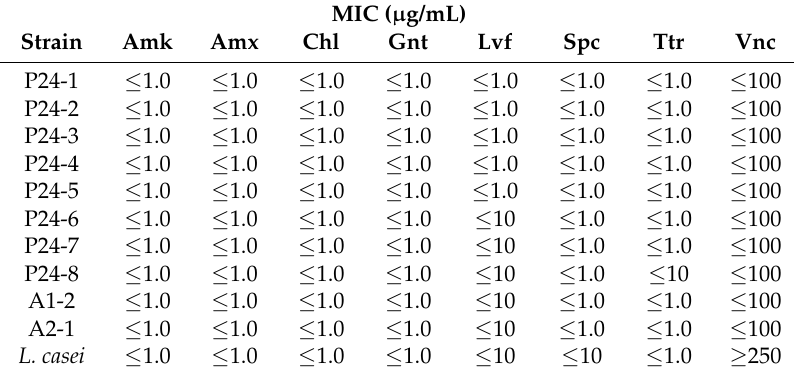
Table 1. MIC (minimum inhibitory concentration) values for the isolated